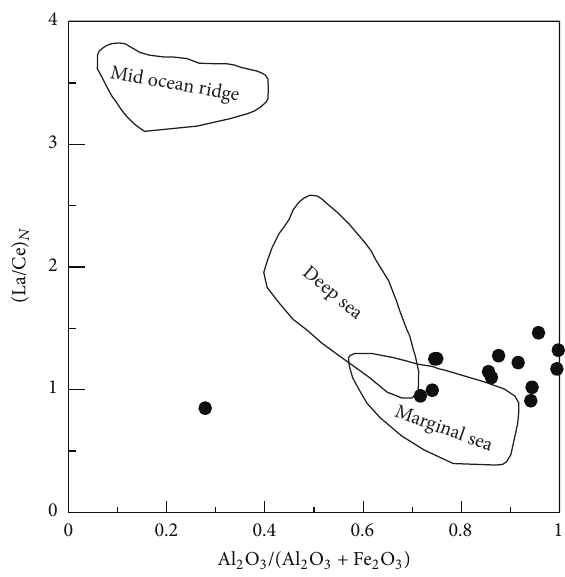
Figure 15: Al 2 O 3 /(Al 2 O 3 + Fe 2 O 3 ) − ( La / Ce ) 𝑁 discrimination diagram for siliceous rock of the Bafangshan-Erlihe area (After-